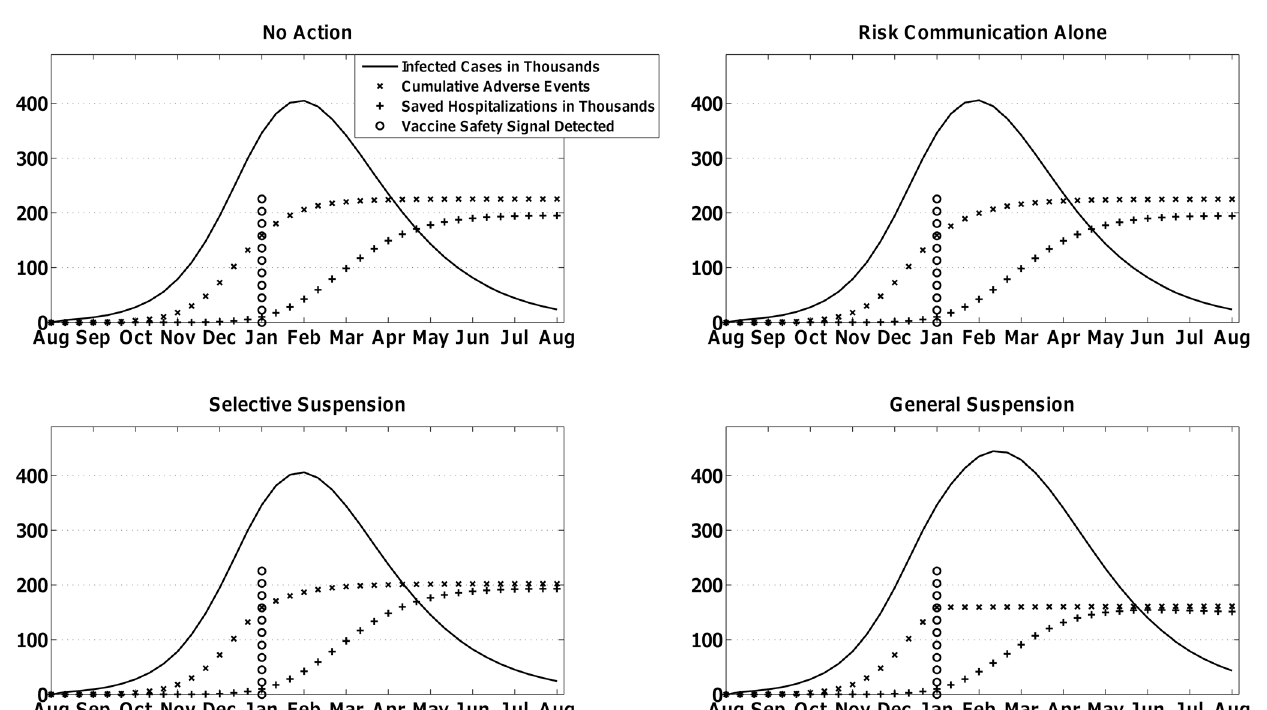
Fig. 2. One simulation run of the mild scenario with a Guillain-Barre Syndrome safety signal received four months after the start of the vaccination campaign, i.e., January, which is five months after the start of the influenza pandemic scenario. The Multi-Criteria Decision Analysis model selected Risk Communication Alone or Selective Suspension as the preferred regulatory